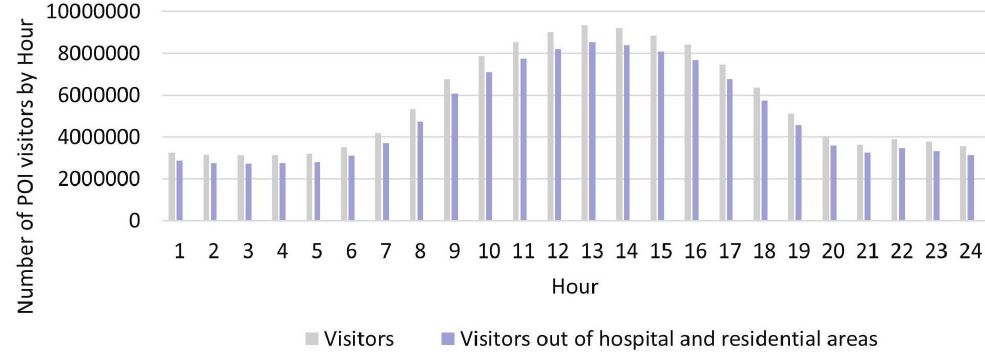
Figure 2. Number of POI visitors by Hour in Washington